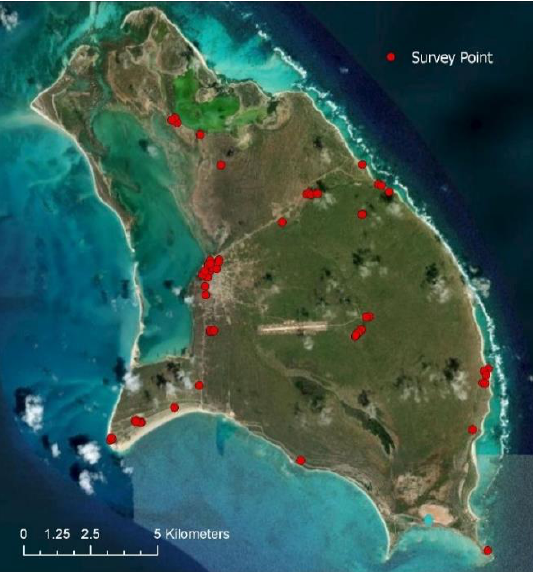
Figure 5: Location of survey points collected in January 2019.